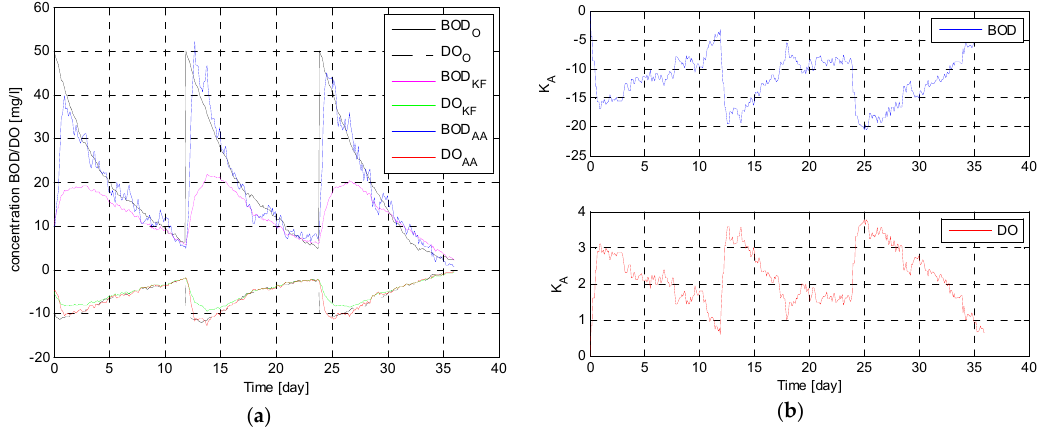
Figure 11. Distribution of BOD and DO signals ( a ) and adaptive algorithm gain coefficients ( b ) for matrices W = [6, − 4; − 4, 2] and V = [0.9].